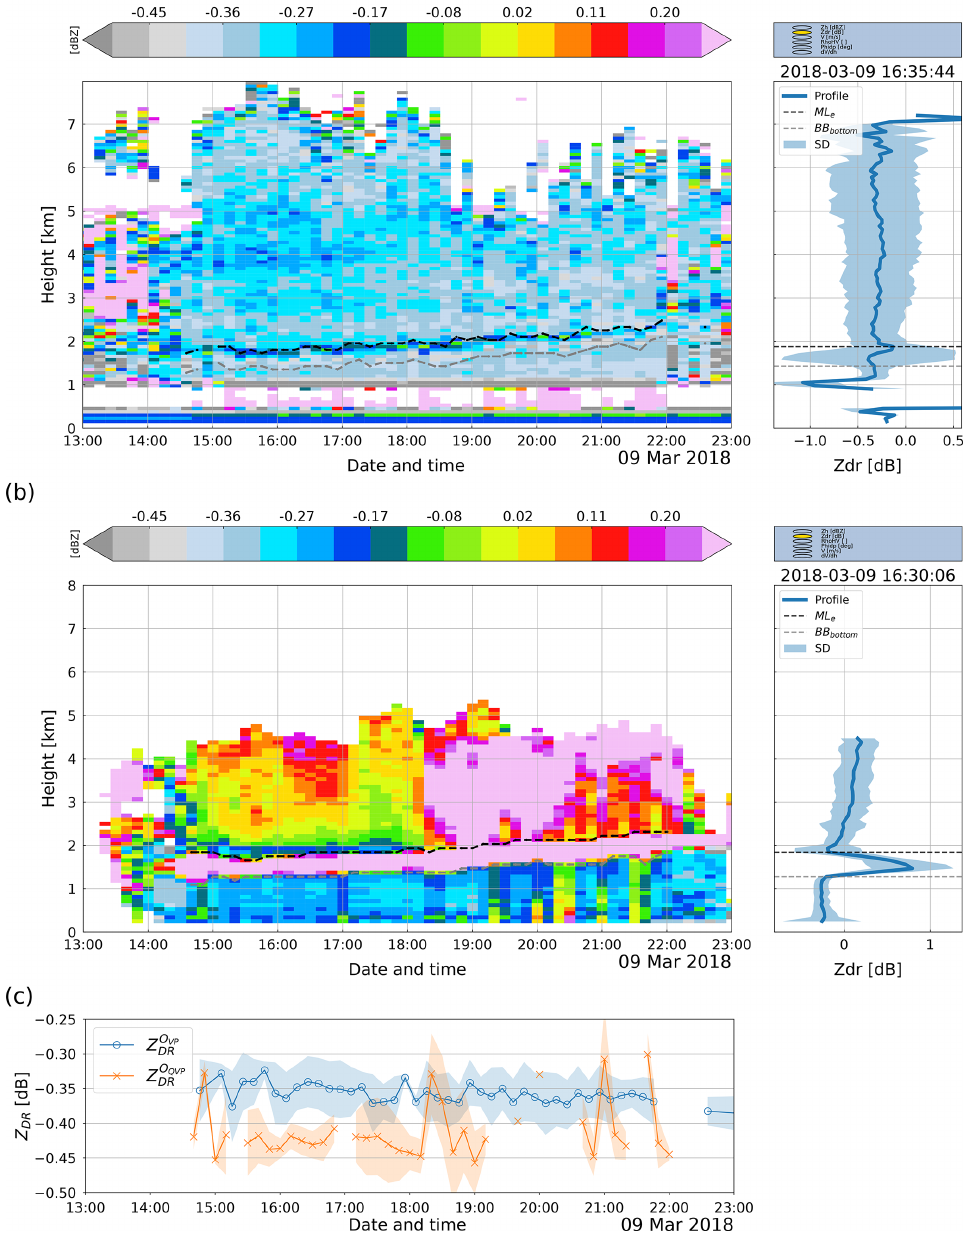
Figure 5. Rain event recorded by the UKMO Chenies radar on 9 May 2018. Panel (a) shows a collection of Z DR VPs in a height-versus-time plot along with the melting level (ML e ) and the bottom of the melting layer (BB bottom ). Its right panel depicts a single VP and its standard deviation (SD). Panel (b) shows the same as in (a) but using QVPs of Z DR . Panel (c) shows the Z DR offset computed using VPs (blue line, circle markers) and QVPs (orange line, cross markers); the filled areas represent the computed standard deviation for each data